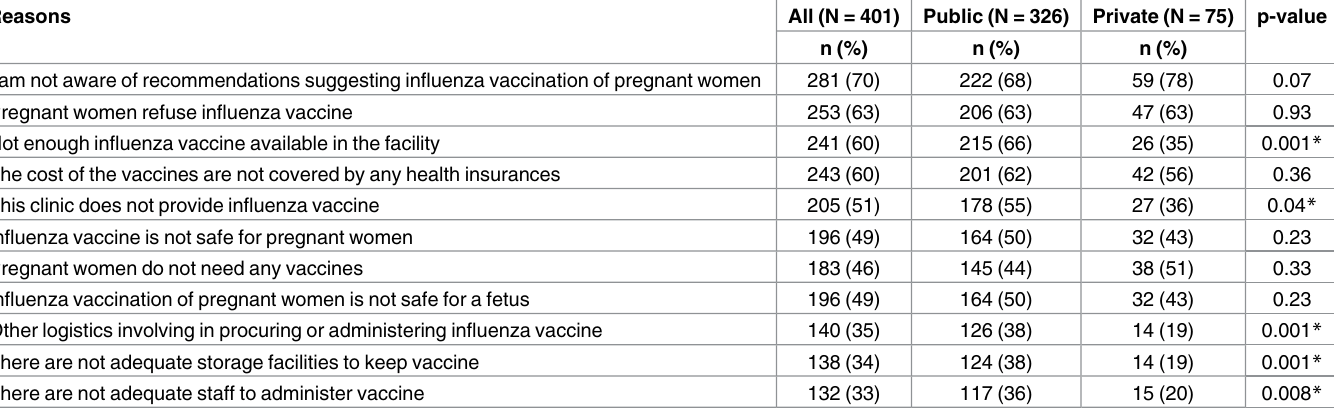
Table 5. Comparison of reasons for not recommending vaccines to pregnant women by Thai physicians in public and private hospitals (N = 401). Reasons